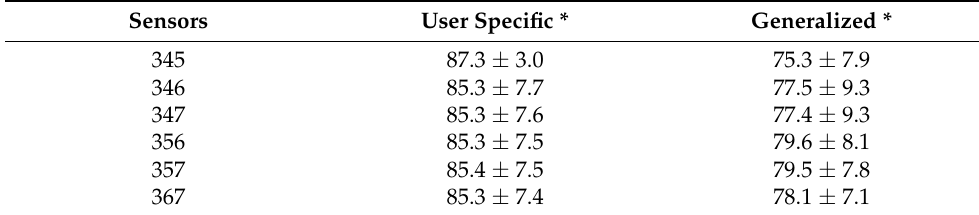
Table 7. Classification results for different sensor combinations when assessing model performance using varying transmitter sensor placements after training the model based on the data of sensors 3, 4, and 5. Shown are mean accuracies (%) and the corresponding standard deviation of all seven subjects when developing user-specific or generalized models.